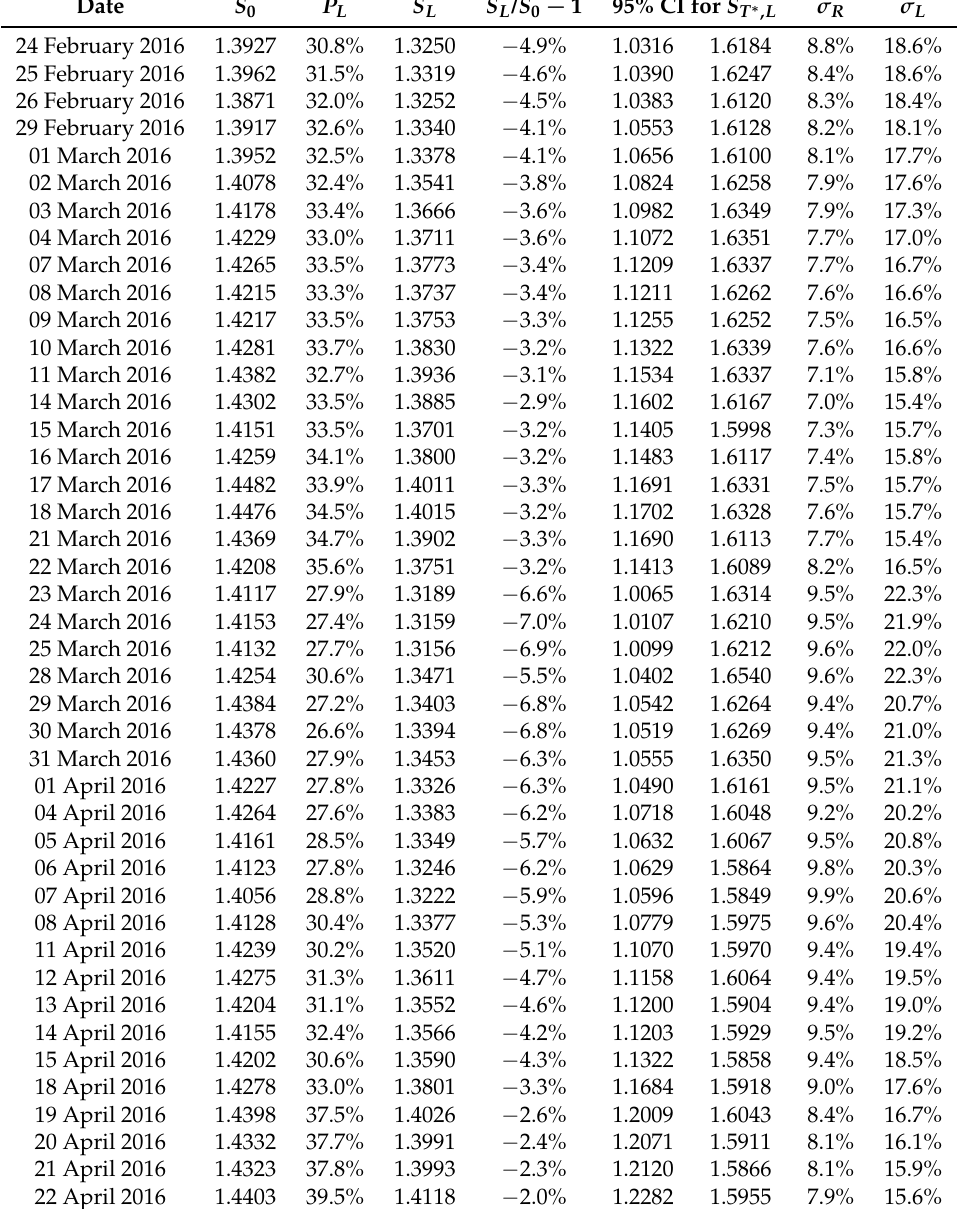
Table 1. Calibrated mixture model parameters from 24 February to 22 April